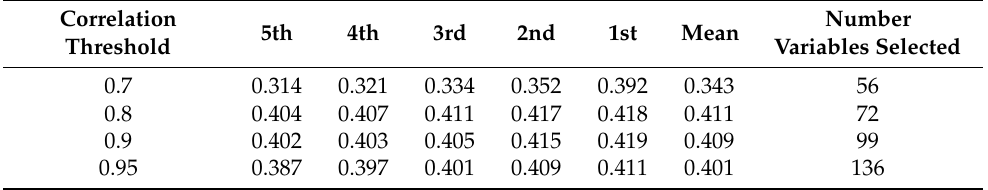
Table 4. Kappa scores of the 5 best 10-fold cross-validation results and their mean for different correlation thresholds. The name of the 1st to 5th indicate the 1st to 5th best kappa scores. The “number variables selected” is the number of variables kept after highly correlated variables removal.